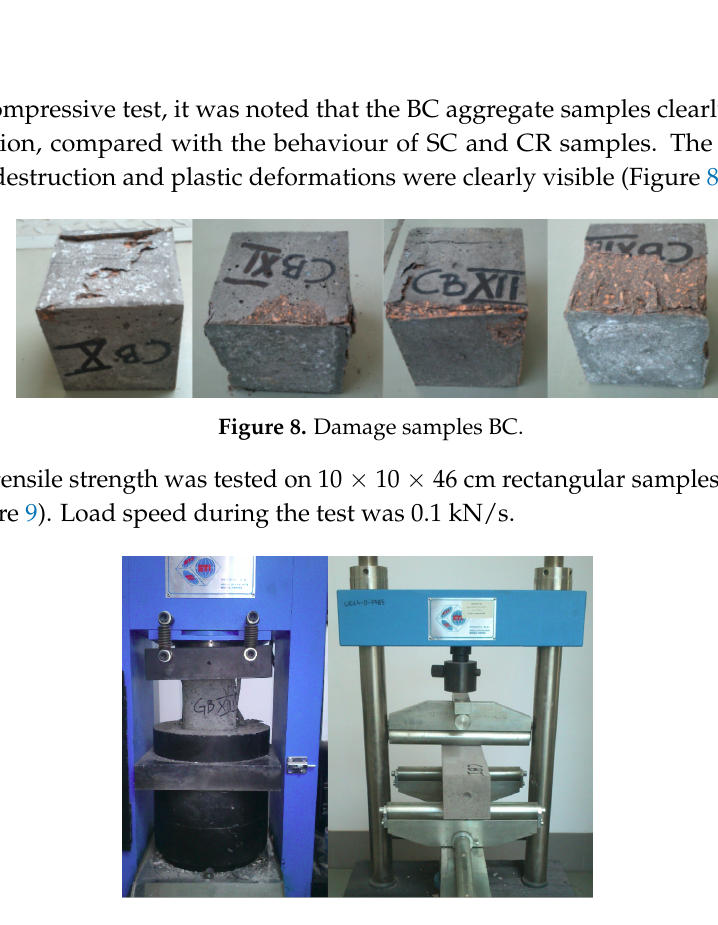
Figure 9. Sample during test of compression and tensile strength in bending.